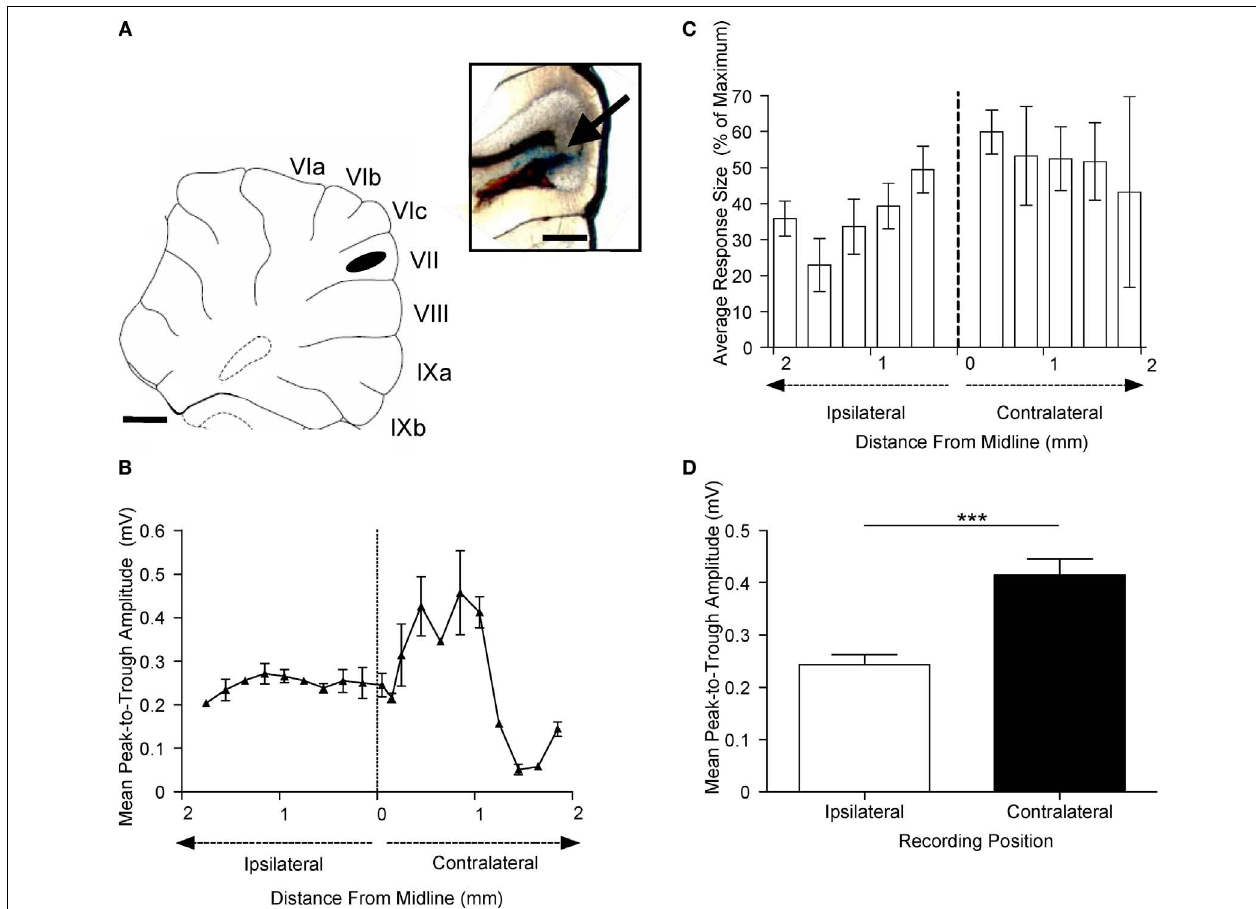
FIGURE 2 | Detailed mapping of responses in vermal lobule VII evoked by PrL stimulation. (A) Standard cerebellar saggital outline (adapted from Paxinos and Watson, 2005) showing lobule of largest evoked fi eld potentials (black spot). Inset shows histological verifi cation at higher magnifi cation (blue spot, arrowed). (B) Typical example of changes in fi eld potential amplitude as a function of medio-lateral recording position on the surface of lobule VII. Each data point represents the mean of four responses ± s.e.m. Cerebellar paravermal veins are located ∼ 0.5 mm lateral from the lateral-most recording points. (C) Pooled data